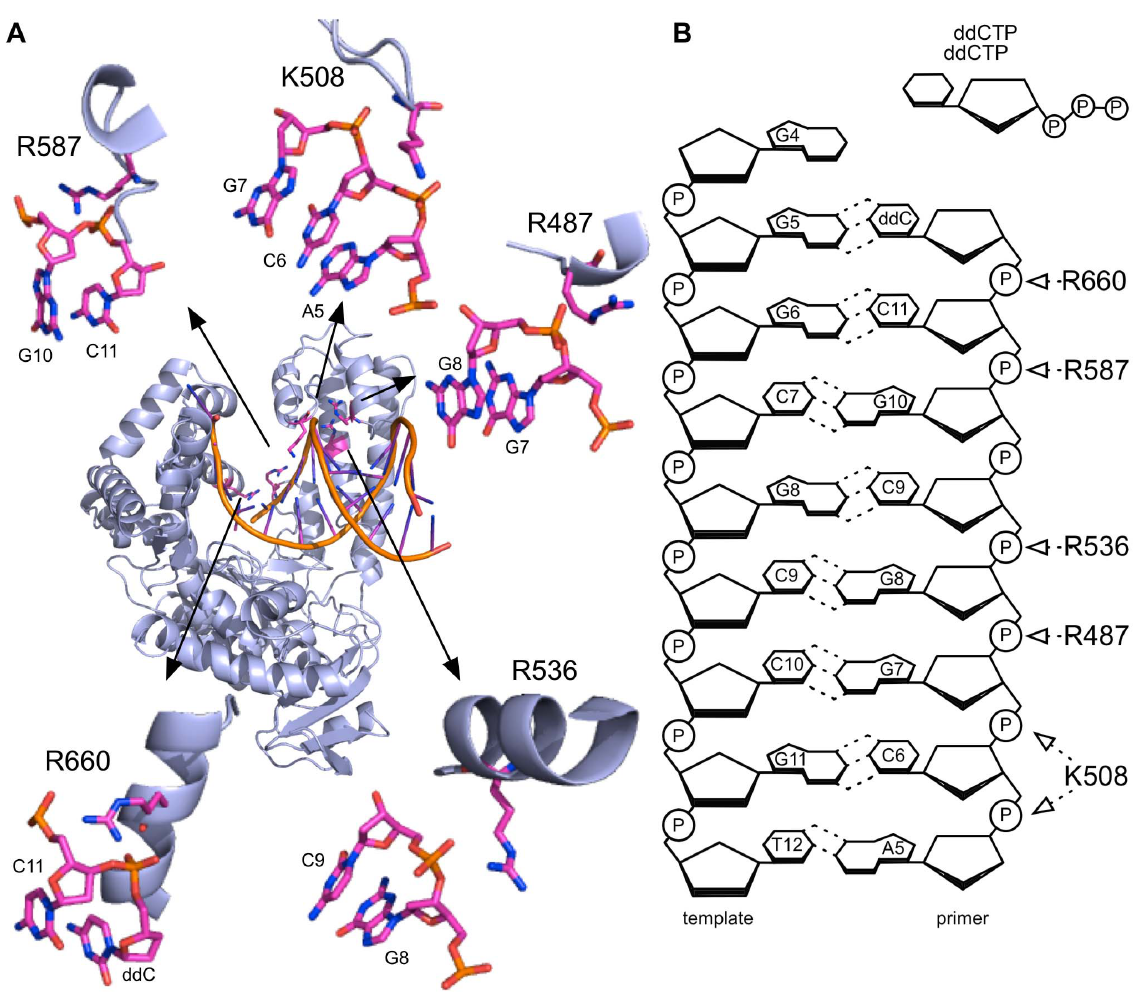
Figure 1. Investigated mutation sites in KlenTaq . A) Crystal structure view showing the active ternary complex of KlenTaq . The enlarged sections show the interaction of the amino acid of interest with the phosphate of the primer backbone (PDB-code 3KTQ[68]). B) 2D-schematic drawing of the DNA substrate, template (left) and primer (right). Arrows indicate the interaction of the amino acids according to [68].